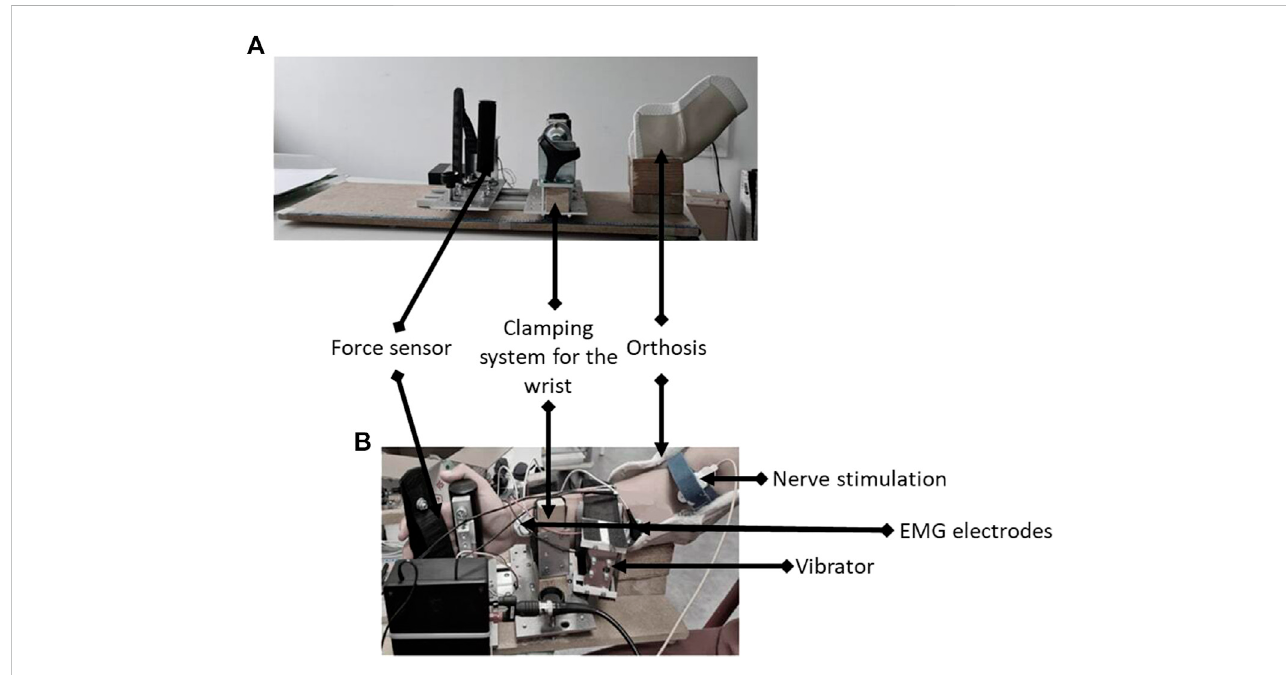
FIGURE 2 Illustration of the custom-built ergometer (A) with placement of the vibrator and nerve bipolar bar stimulating electrode (B) .